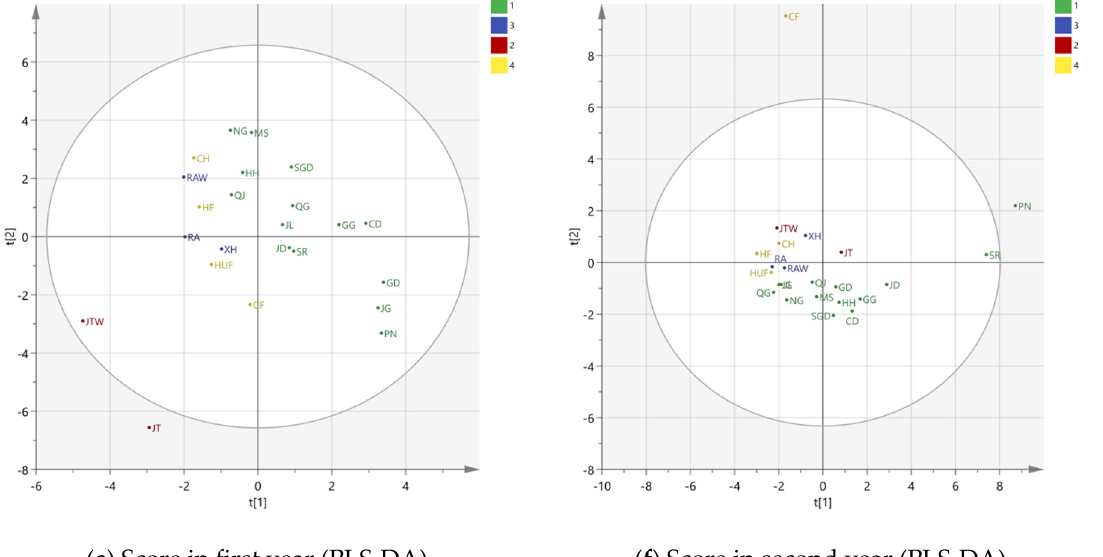
Figure 3. PCA and PLS-DA scores and loading plots over two years. ( a ) PCA score plot in first year; ( b ) PCA loading plot in first year; ( c ) PCA score plot in second year; ( d ) PCA loading plot in second year; ( e ) PLS-DA score in first year; ( f ) PLS-DA score in second year. In Figure 3b,d, 1 to 39 represent the volatiles detected in HS-SPME-GC-MS, detailed information is listed in Table 2. The apple cultivar abbreviation codes are described in Table 1. In Figure 3e,f, 1 = cultivar. Golden Delicious, 2 = cultivar. Jonathan, 3 = cultivar. Ralls and 4= cultivar. Fuji.